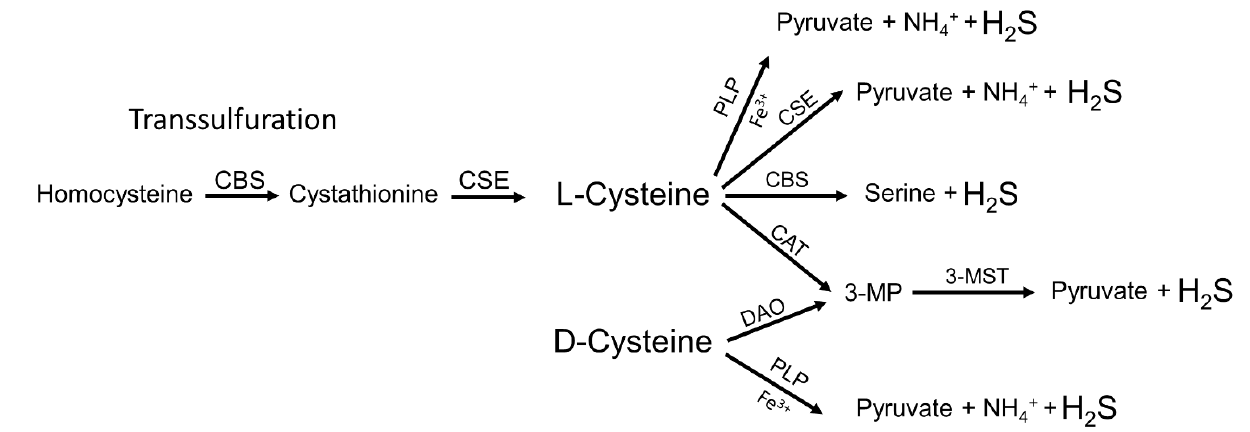
Figure 1. Enzymatic and non-enzymatic synthesis of H 2 S. The enzymatic synthesis of H 2 S by CSE, CBS, 3-MST and DAO as well as the non-enzymatic pathway catalysed by Fe 3+ and PLP are presented. Please note that H 2 S is also formed by CBS and CSE through other steps of the transulfuration pathway [13]: This is a modification of Fig. 1C from Beck and Pfeilschifter [6]. CAT, cysteine aminotransferase; DAO, D-amino acid oxidase; 3-MP, 3-mercaptopyruvate; 3-MST, 3-mercaptopyruvate sulfurtransferase; CBS, cystathionine- β -synthase; CSE, cystathionine- γ -lyase; and PLP, pyridoxal phosphate.